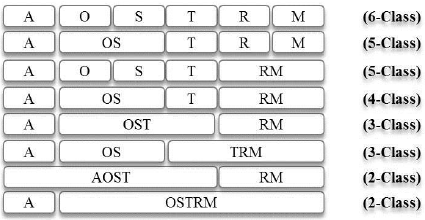
Figure 4. Different levels of the final 1975, 1995, 2005, and 2013 classifications tested, from 2 classes to 6 classes. A = Alpine, O = Open, S = Stand Initiation, T = Thin, R = Advanced Regeneration, M = Mature. See Supplementary Material: Dictionary S1: Definitions of Forest Structure Classes for